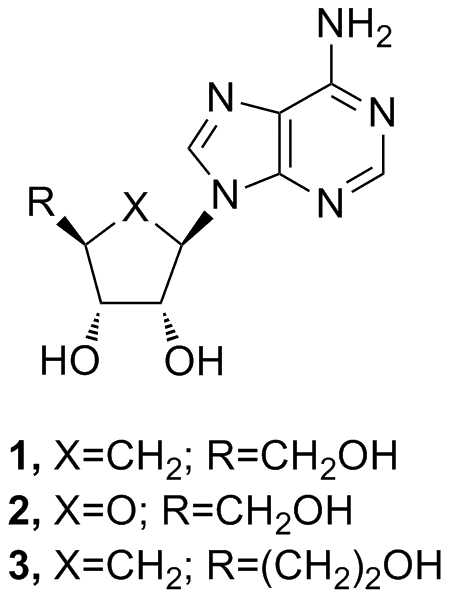
Chemical structure of MY-24 and derivatives.Aristeromycin (1), adenosine (2), 5′-homoaristeromycin (MY-24)(3).